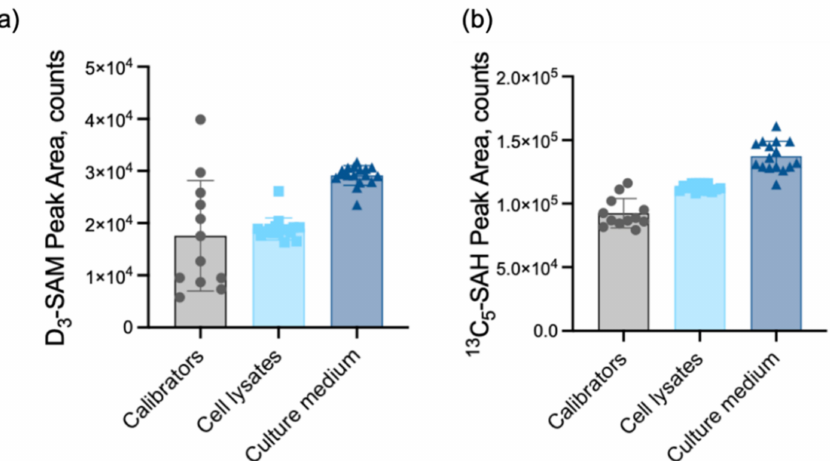
Figure 4. Analysis of the matrix effect for studies with cultured cells. ( a ) Comparison of peak areas of D 3 -SAM in the absence of matrix (calibrators, prepared in 0.1% formic acid in water), with extracted cell lysate or culture medium. ( b ) Comparison of peak areas of 13 C 5 -SAH in the absence of matrix (calibrators, prepared in 0.1% formic acid in water), with extracted cell lysate or culture medium. Circles: Pure calibrators; Squares: Cell lysate as matrix; Triangles: Culture Medium as